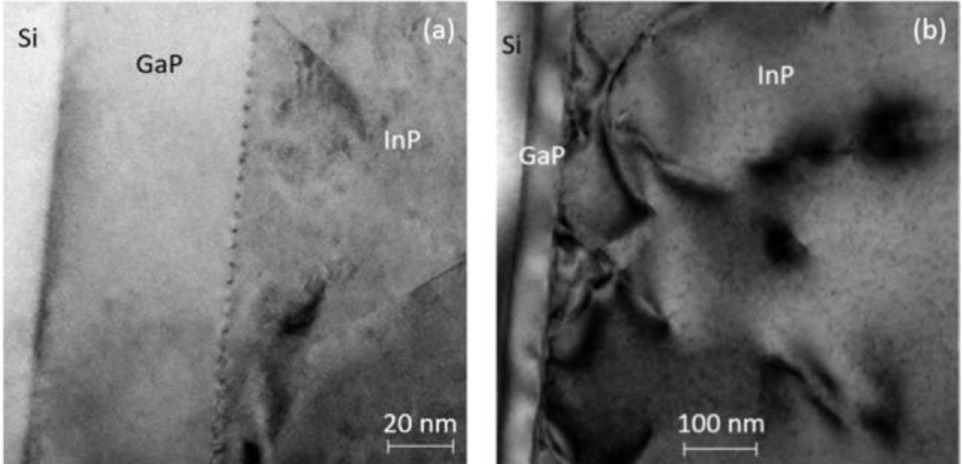
Fig. 7. TEM images of the cross section showing the Si/GaP/InP template; (a) Points out the evaluation of mis fi ts periodicity, (b) Illustrates some crystalline defects arising from the high mismatch.